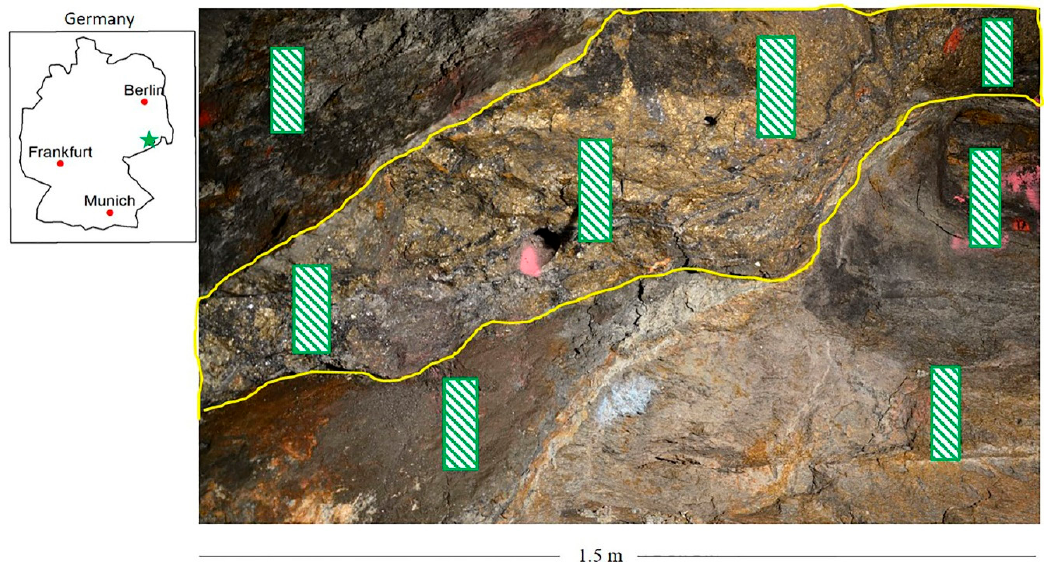
Figure 1. Location of the study site (the green star on the inset map) and underground mine face photo. The yellow line shows the boundaries of the ore zone. Outside of the ore zone, the host rock is gneiss. Some of the locations of the 58 samples used in this study are indicated in green boxes.